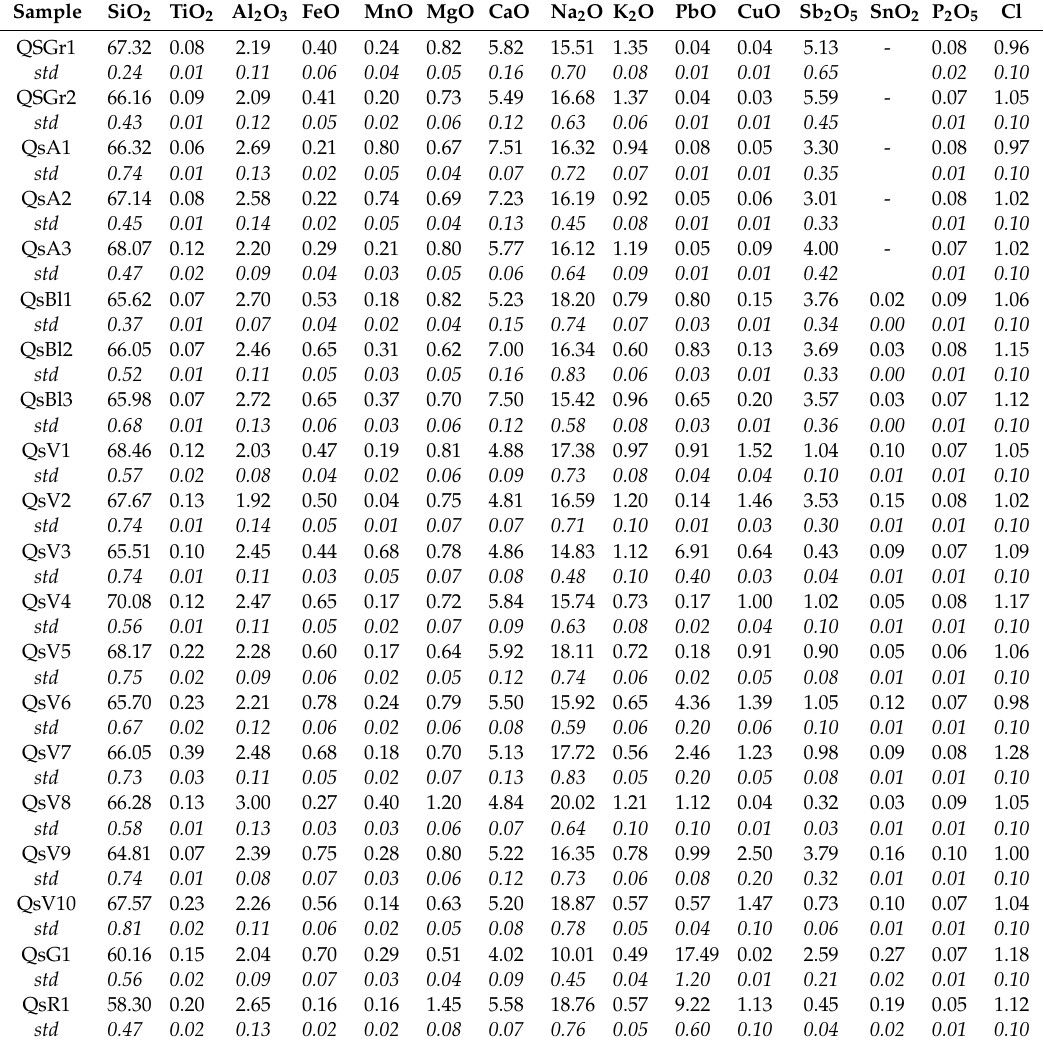
Table 2. Major element concentrations in wt.% of oxides determined by Electron Probe Micro Analyser with Wavelength-Dispersive Spectroscopy (EPMA-WDS). Sample